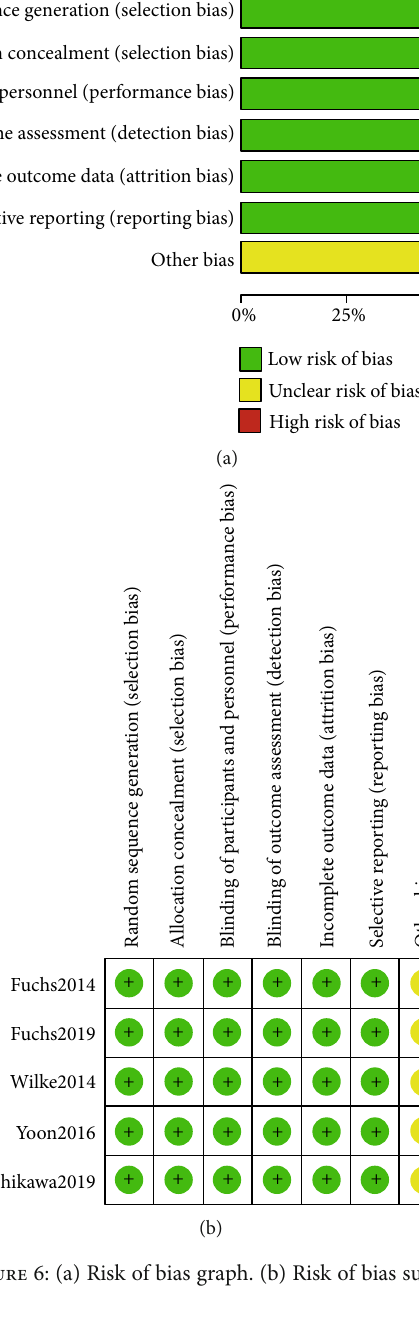
Figure 6: (a) Risk of bias graph. (b) Risk of bias